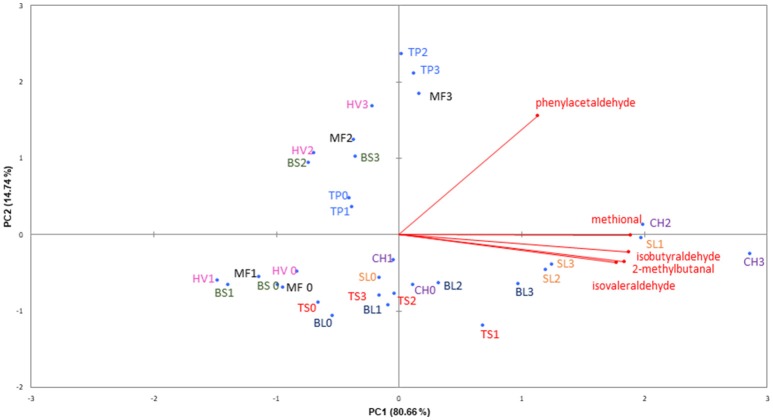
PCA plot with data from Strecker aldehydes normalized by the consumed oxygen not invested in the oxidation of sulfur dioxide.